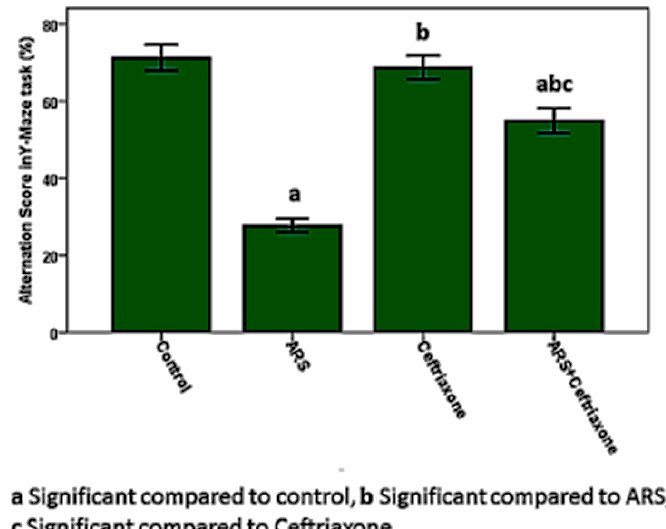
Figure 2. Alternation score in the Y-maze task.